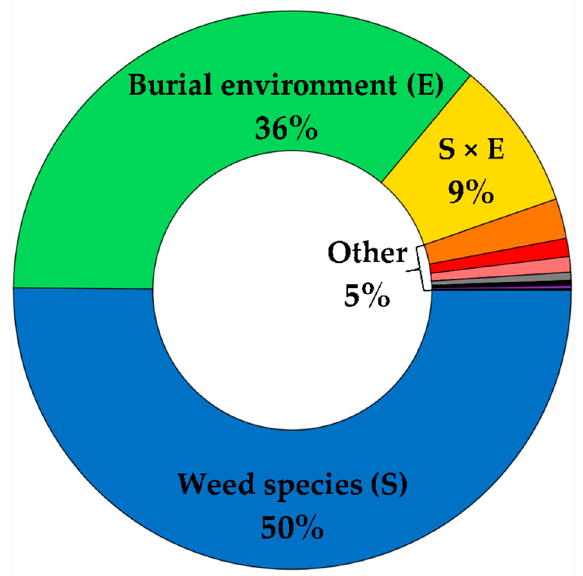
Figure 1. Percent of total variance allocated to each factor included in the linear mixed effects model for seed survival of kochia, wild oat, and volunteer canola in a 7 week bioassay experiment planted to wheat, canola, and field pea. Other includes all remaining fixed and random factors.